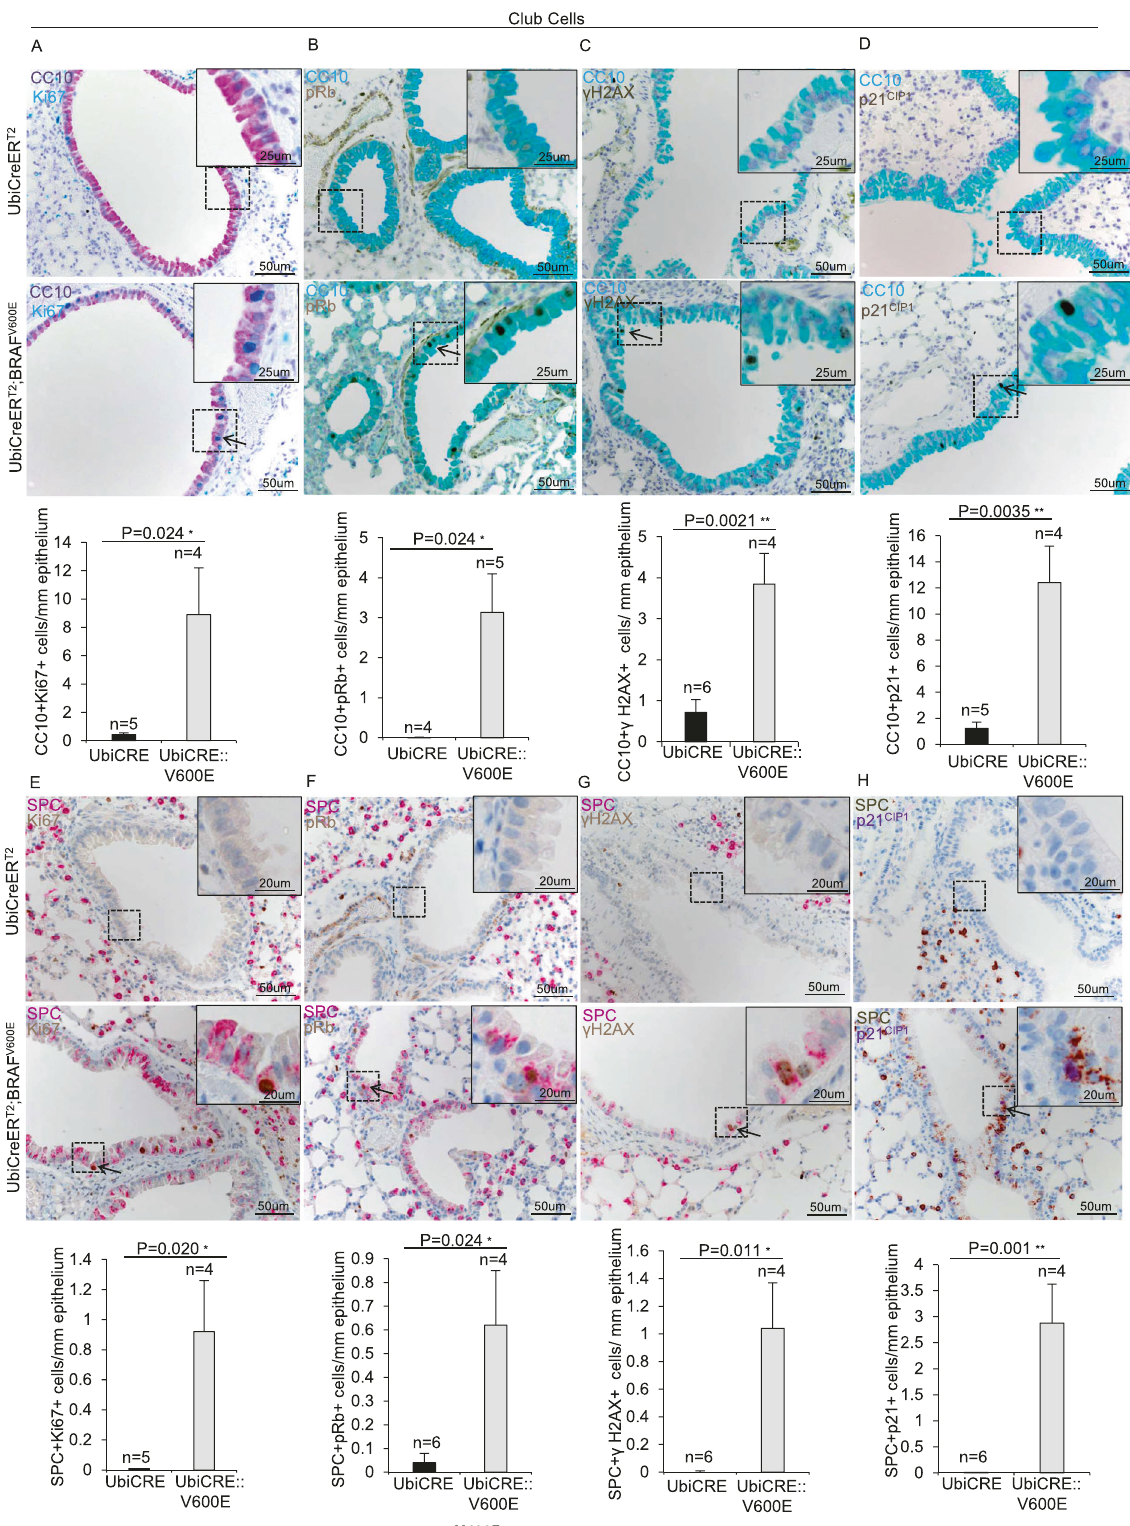
Fig. 6 Analysis of the early molecular response of BRAF V600E induction in Club cells. A – D Representative images (top) and quanti fi cations (bottom) showing CC10 + cells staining positive for A Ki67, B pRb, C γ H2AX, D p21 CIP1 double immunostainings in lung sections from BRAF V600E and control mice. E – H Representative images (top) and quanti fi cations (bottom) showing bronchial/bronchiolar SPC + cells staining positive for E Ki67, F pRb, G γ H2AX, H p21 CIP1 double immunostainings in lung sections from BRAF V600E and control mice. Quanti fi cations were performed on at least fi ve different areas of the lung sections in a random way. Data are expressed as mean ± SEM; n = animals per group. * P < 0.05; ** P < 0.01; *** P < 0.001, ns = not signi fi cant. (T Student ’ s test unpaired). Arrows point to selected positive cells for the indicated marker. Insets: magni fi cations of areas inside dashed squares.